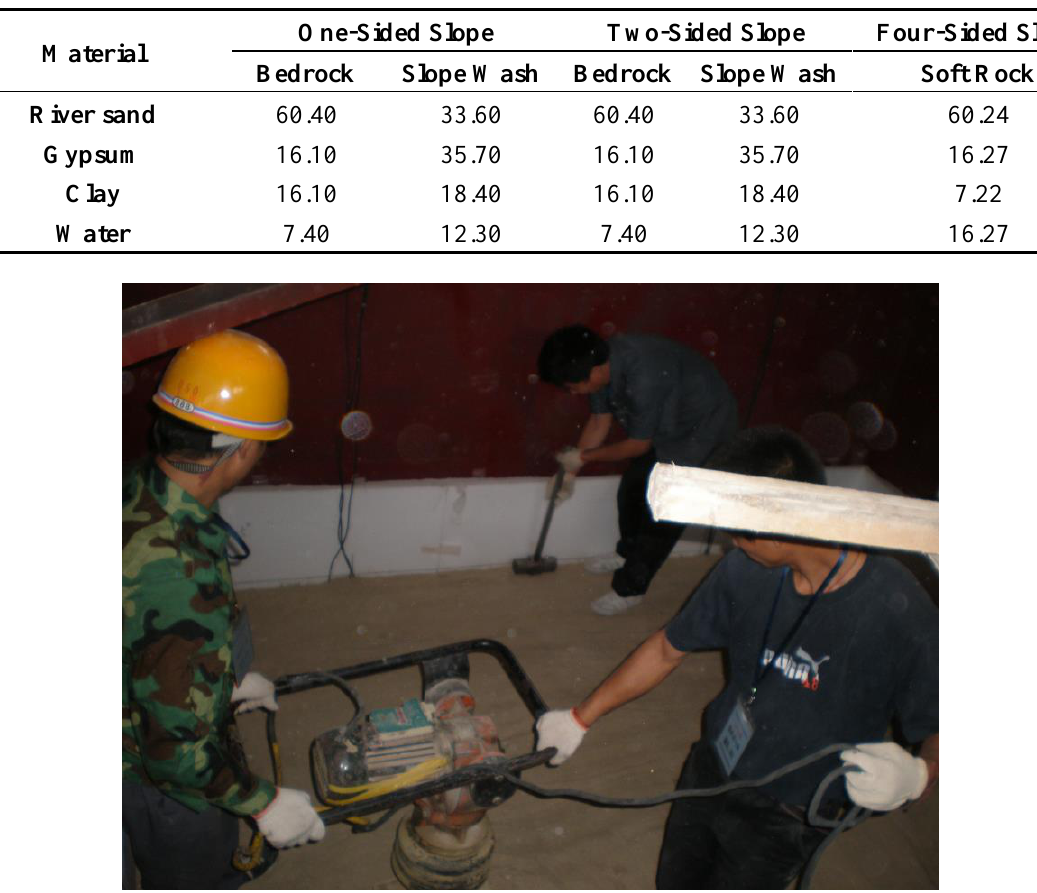
Figure 7. Artificial consolidation and mechanical